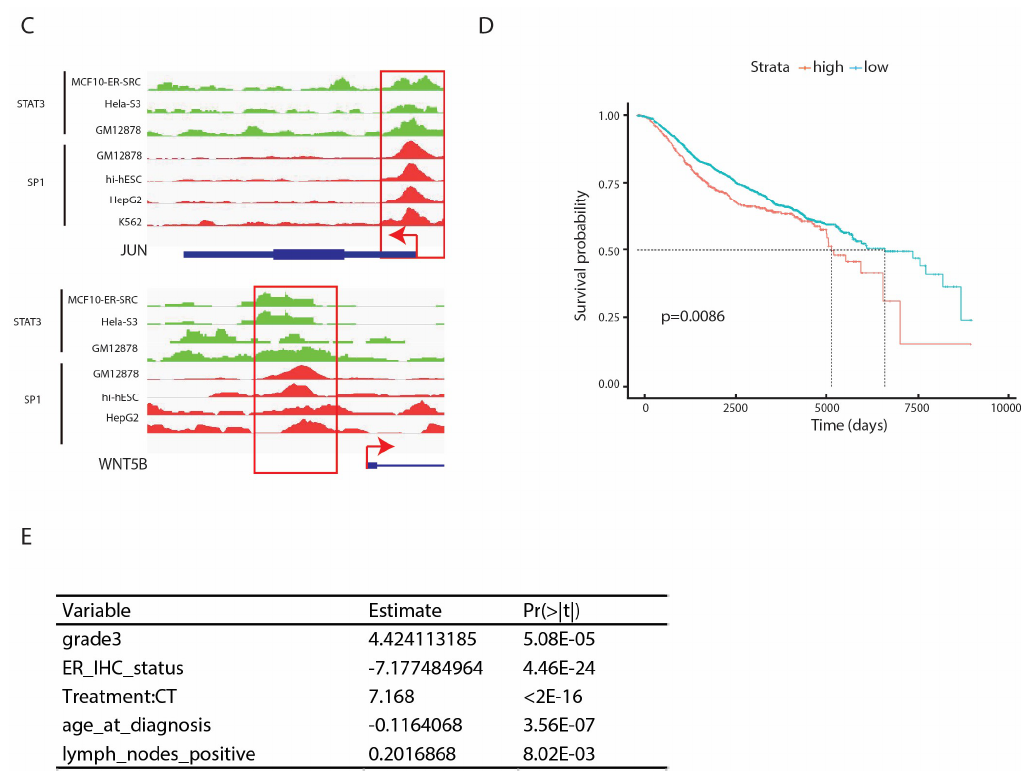
Figure 5. Concomitant activation of STAT3 and SP1 is associated with poor prognosis in breast cancer. ( A ) SP1 binding to the RHOU promoter measured by ChIP assay in MDA-MB-231 cells cultured in the presence or absence of Mit. A. Data are mean ± SEM of the fold enrichment obtained with anti-SP1 antibodies versus IgGs in three independent experiments. ** p < 0.005 ( B ) Bar plot showing the gene sets significantly enriched for STAT3 and SP1 bound genes. ( C ) IGV genome browser pictures showing binding of both SP1 and STAT3 in the indicated cell lines. Green: STAT3; Red: SP1. Two representative genes of the two top-ranking gene sets in ( B ), WNT5B and JUN, are shown. ( D ) Kaplan-Meier plot of overall survival for breast tumor patients, as a function of time in days. Patient samples from the METABRIC database (https://www.synapse.org/#!Synapse:syn1688369/) were subdivided according to low or high SP1-S3 score (median value). ( E ) Results of generalized linear models correlating grade, ER status, treatment, age at diagnosis and lymph node positivity to the SP1-STAT3 score. Coefficients (estimate) of the predictors and significance are indicated.